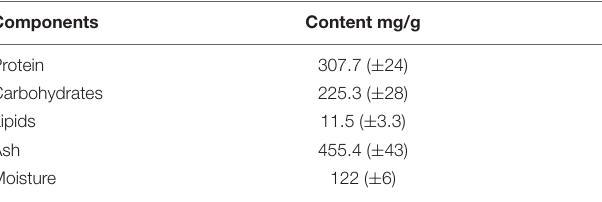
TABLE 1 | Proximate composition of Chlorella sorokiniana